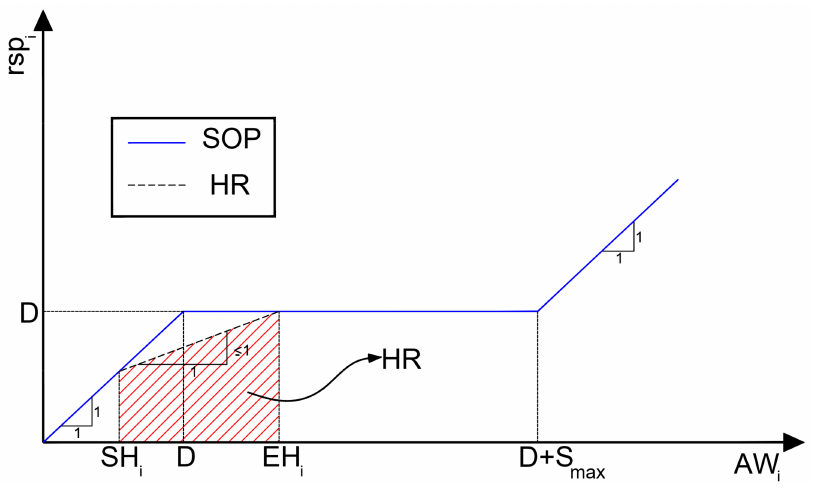
Figure A1. Comparison of HR and